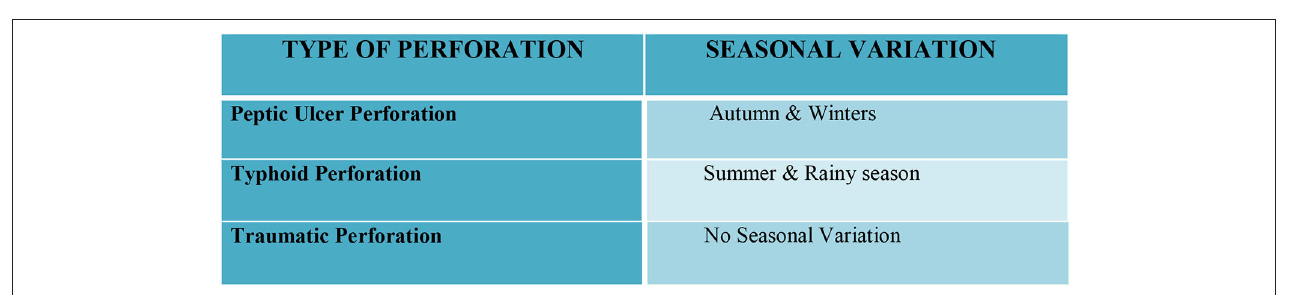
FIGURE 1 | Number of patients in different age groups.